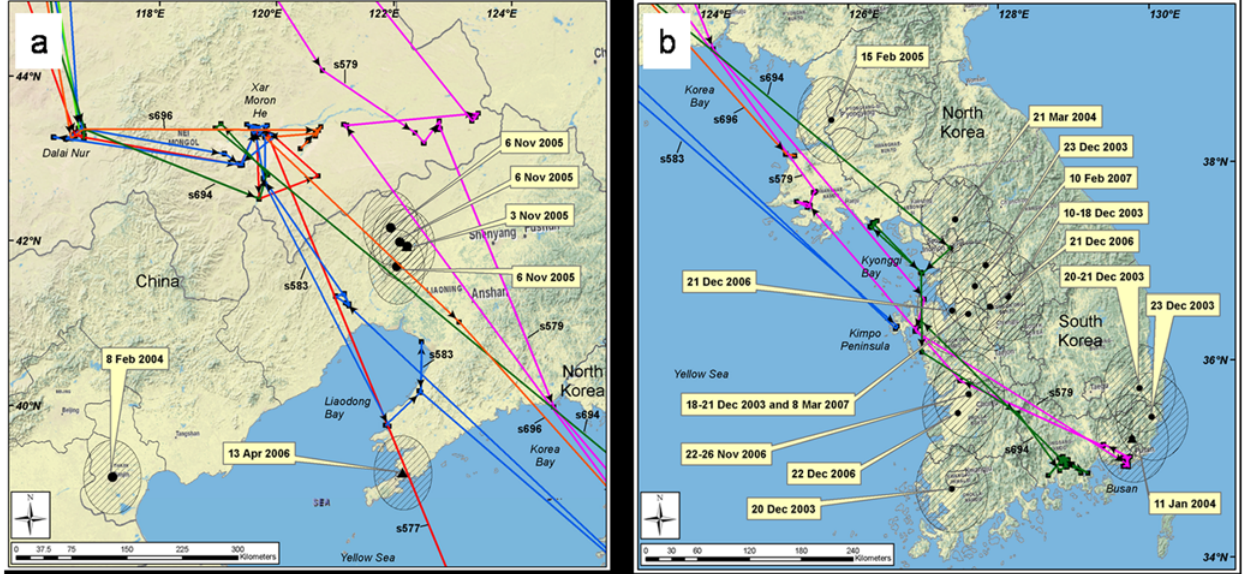
Figure 3. Whooper swan movements (2006–2007) and proximity to HPAI outbreak locations (2003–2007) affecting poultry (circles) and wild non-waterbirds (triangles) in (a) northeastern China and (b) the Korea